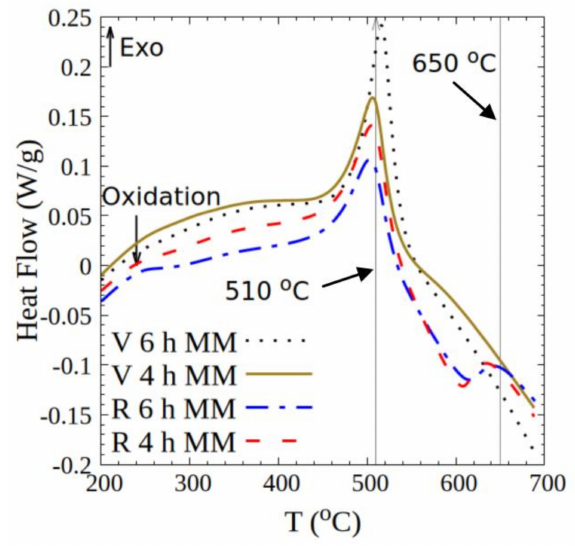
Figure 2. Di ff erential scanning calorimetry (DSC) plots for 4 and 6 h mechanically milled (MM) virgin (V) and recycled (R)